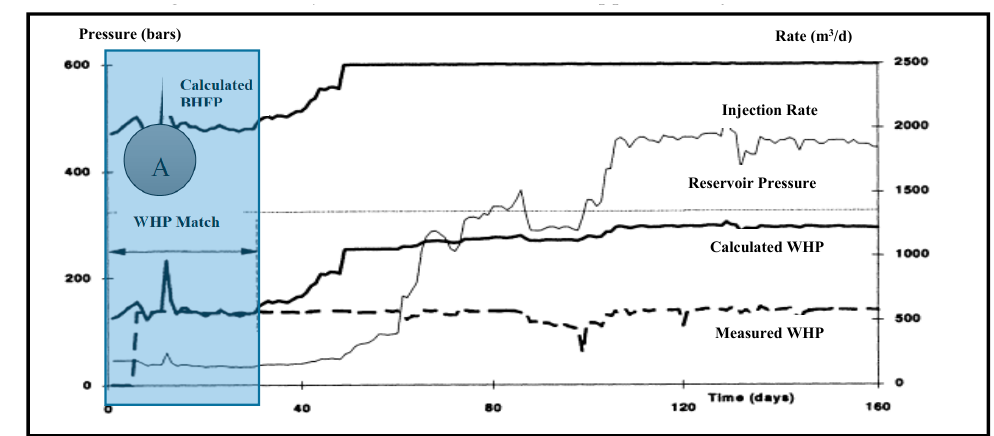
Figure 5. History match assuming radial flow for Well A [5].